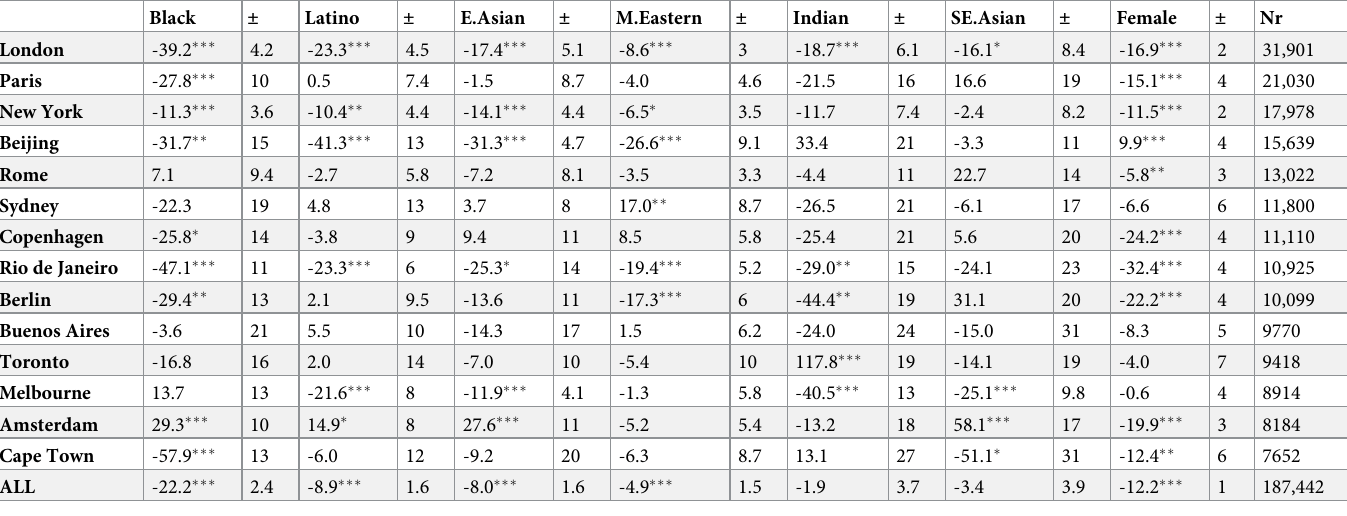
Table 3. The ± column show 0.95 confidence